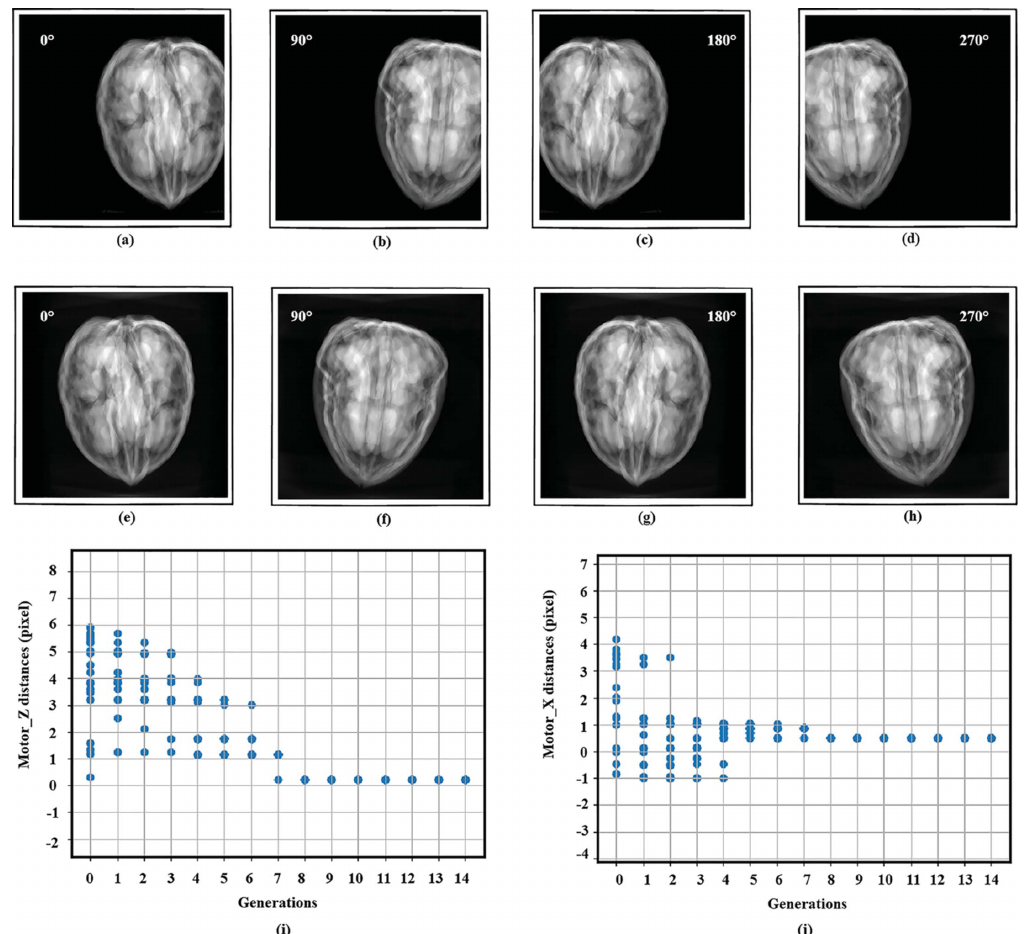
Figure 7 ( a )–( d ) Projection images of the sample before alignment. ( e )–( h ) Projection images after coarse alignment. ( i )–( j ) Sample offset in the x and z directions after each generation when the number of individuals in the population is set to 20 during the fine alignment procedure.